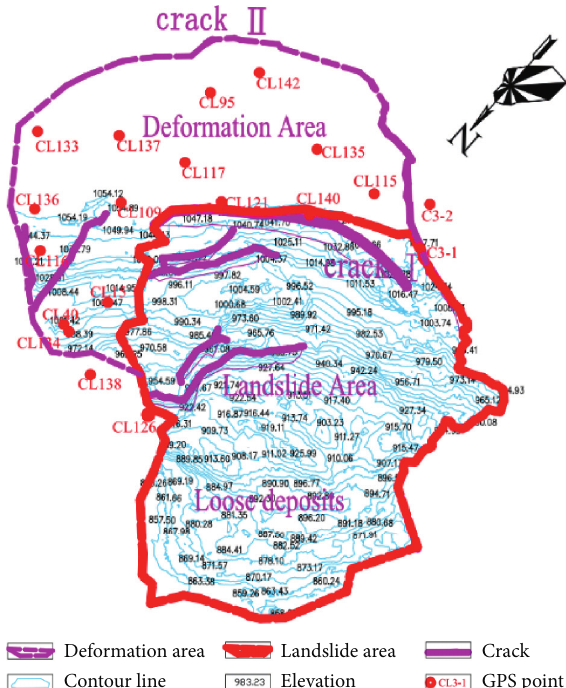
Figure 18: Distribution of monitoring